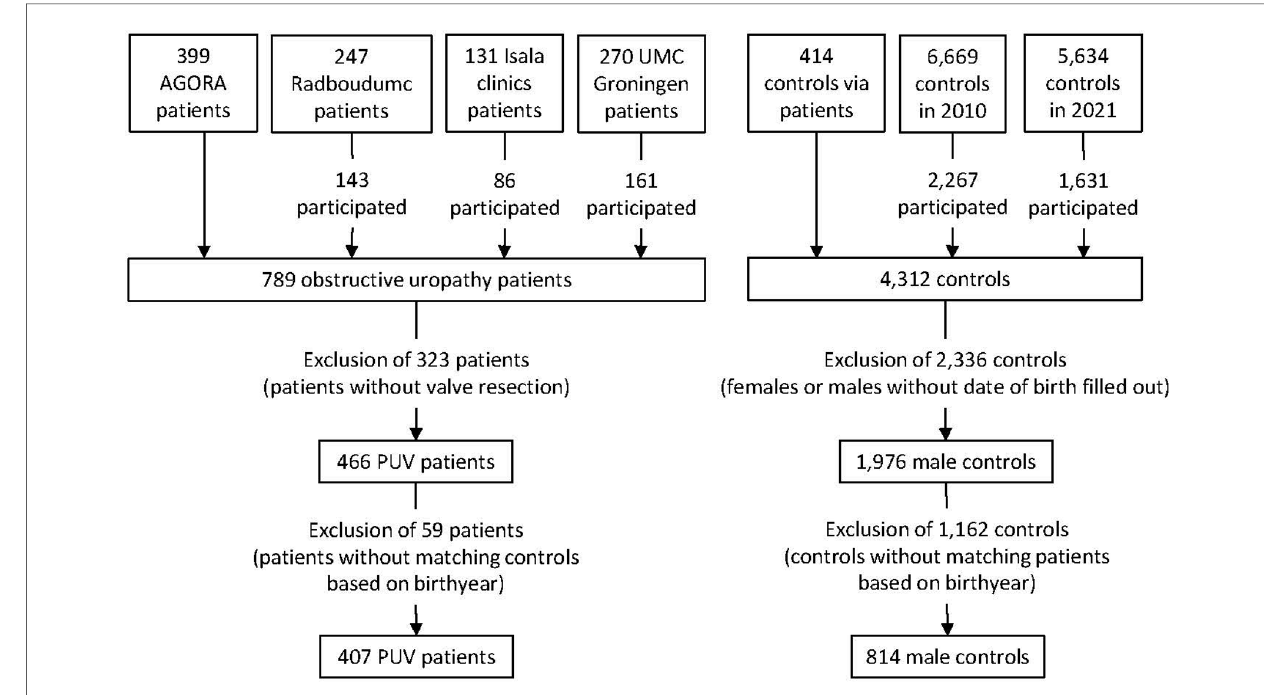
FIGURE 2 Flowchart showing the selection and in- and exclusion of patients and controls in the current study. PUV, posterior urethral